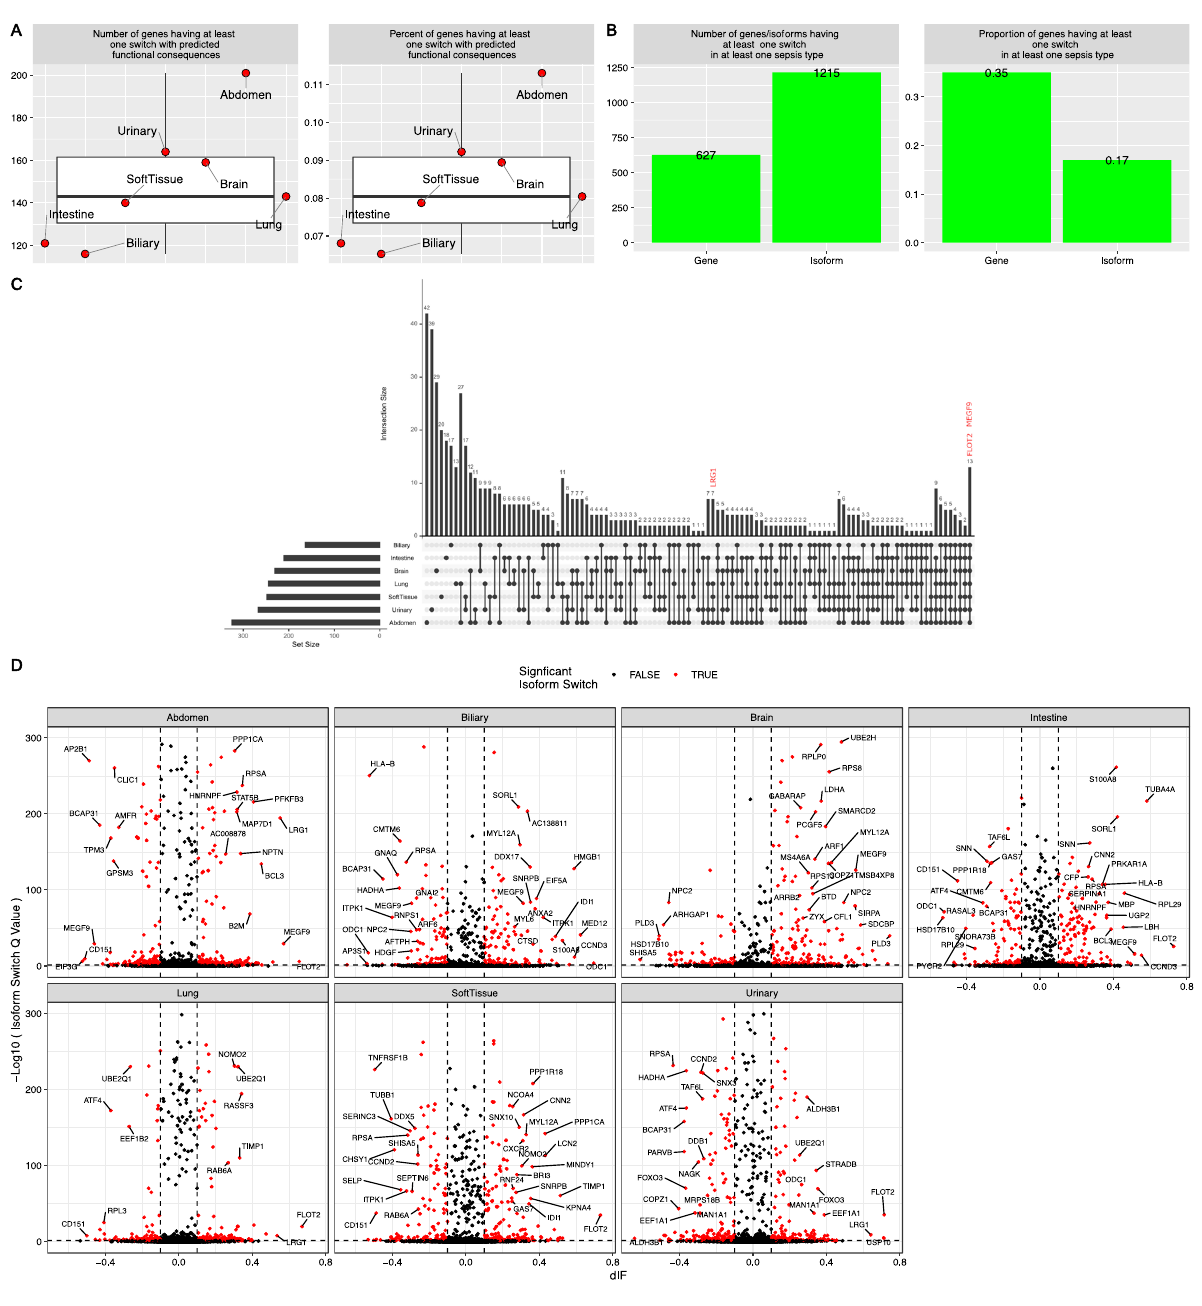
Figure 2. Isoform switching with predicted consequences in patients with sepsis versus controls. ( A ) Extent of isoform switching in different sites of infection. Left, the number of genes undergoing at least one isoform switching in the patients with sepsis compared to that in the controls and predicted to have a functional consequence in each sepsis type. The right panel shows the corresponding fractions of analyzed genes that underwent at least one isoform switching episode. ( B ) The Extent of isoform switching associated with each sepsis type. Bar plots showing the number and proportion of tested genes and isoforms involved in isoform switching with predicted functional consequences associated with at least one sepsis type. ( C ) UpSet plot showing the intersection of genes common to the sepsis types. The bar plot indicates the intersection size (number of genes). For example, the first bar shows that 51 genes underwent at least one significant isoform switch that was unique to abdominal sepsis, and 16 genes underwent at least one significant isoform switch that was common to the lung and abdomen. ( D ) Significant isoform switching as defined by FDR and dIF across all types of sepsis compared to that in controls. Genes with |dIF|> 0.25 and q value < 0.001 were labeled by gene names, and those with |dIF|> 0.1 and q value < 0.05 were labeled by red color. dIF difference in the isoform fraction; FDR false discovery